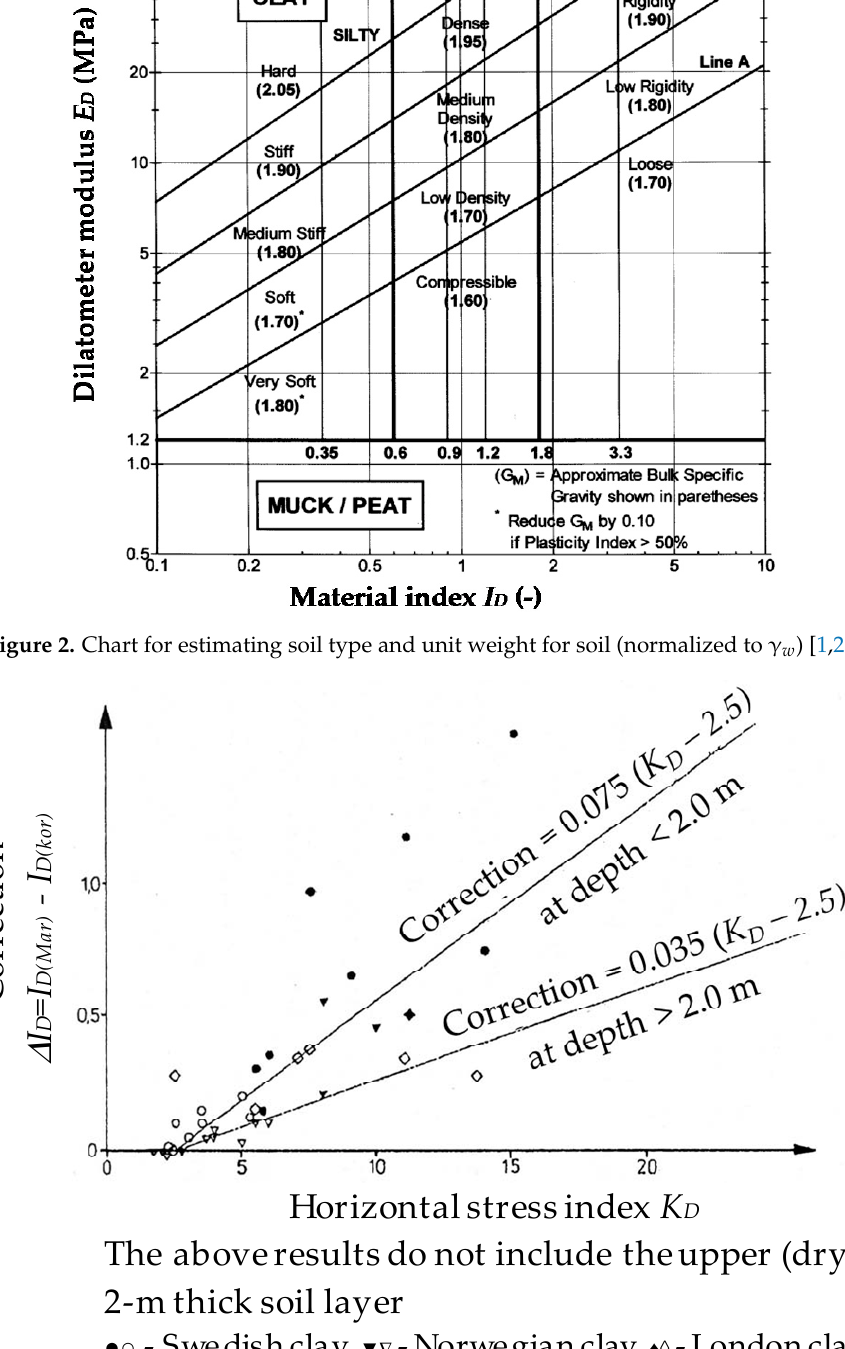
Based on the analysis of dilatometer test results for pre-consolidated cohesive soils and organic soils, Larsson [7] proposed a revision of the value of the material index I D by taking into account the impact of pre-consolidation on the change of its value. The adjusted value of the material index I D(kor) according to Larsson’s recommendations [7] can be determined from the following relationships (Figure 3):